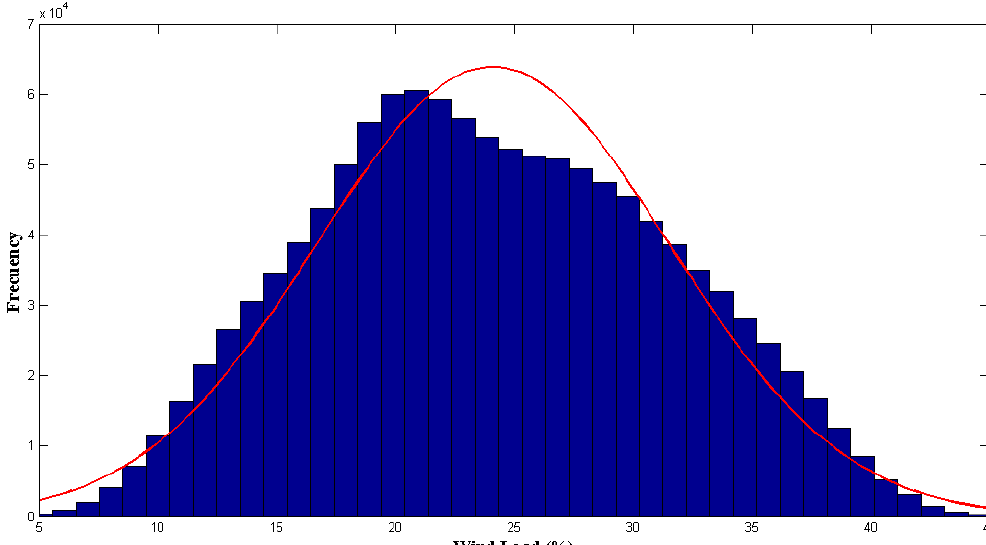
Figure 3. Distribution of wind load